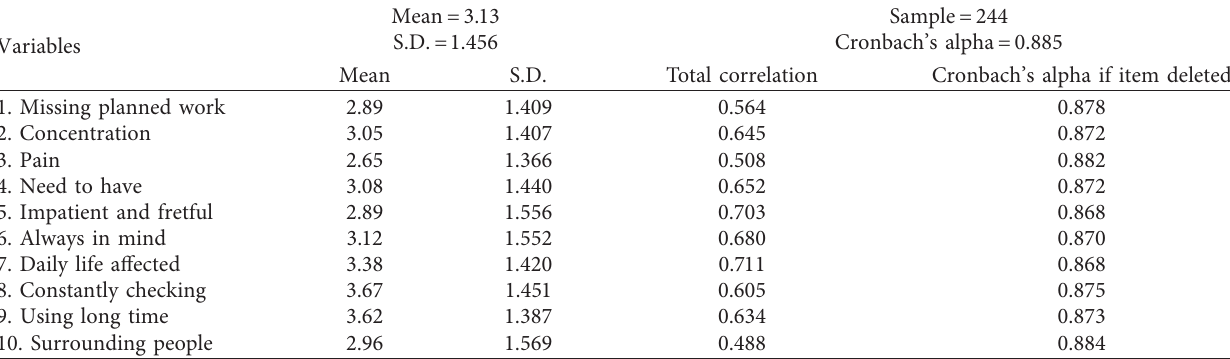
Table 1: Analysis of the items of the smartphone addiction scale.